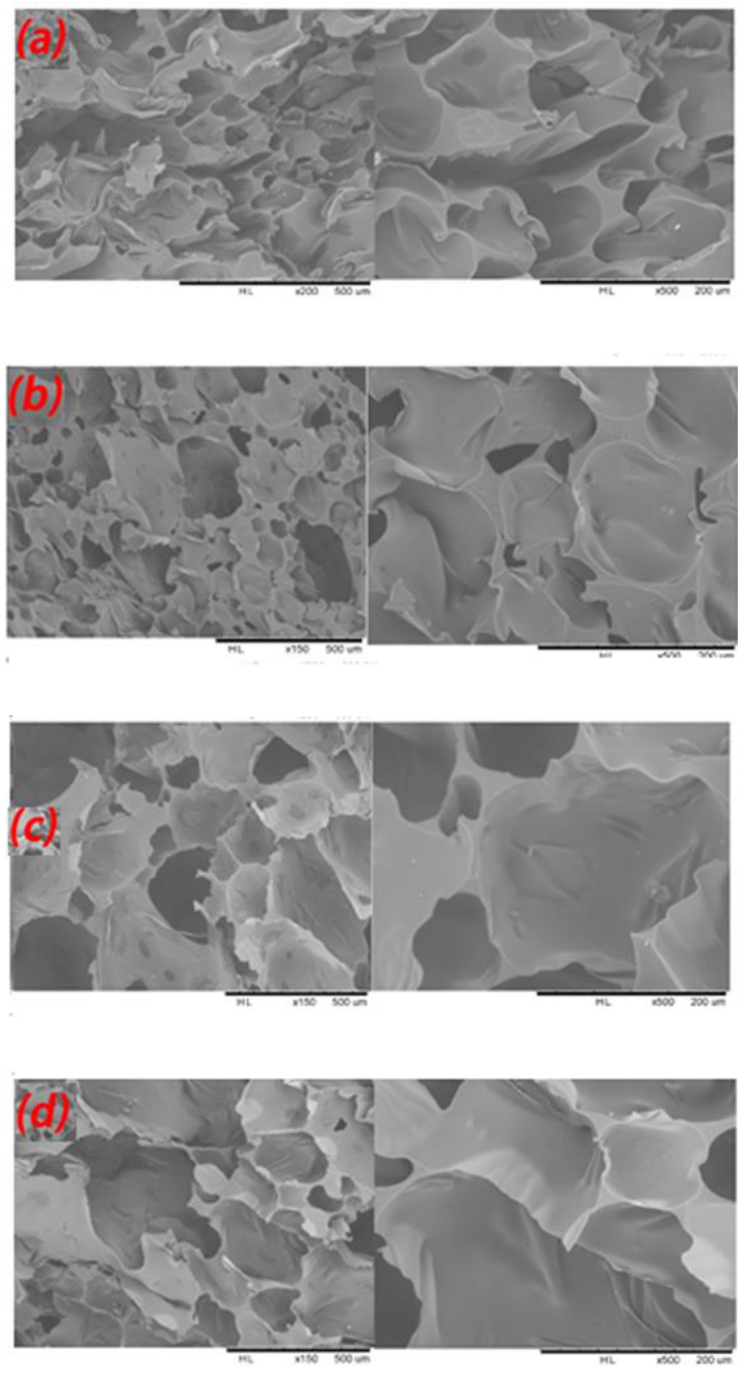
Figure 10. E ff ect on foam morphology of di ff erent proportions of humins. ( a ) F-H2.0-FA6-W1.5; Figure 10. Effect on foam morphology of different proportions of humins. ( a ) F-H2.0-FA6-W1.5; ( b ) F-H3.7-FA6-W1.5; ( c ) F-H4.5-FA6-W1.5; ( d ) ( b ) F-H3.7-FA6-W1.5; ( c ) F-H4.5-FA6-W1.5; ( d ) F-H5.9-FA6-W1.5.